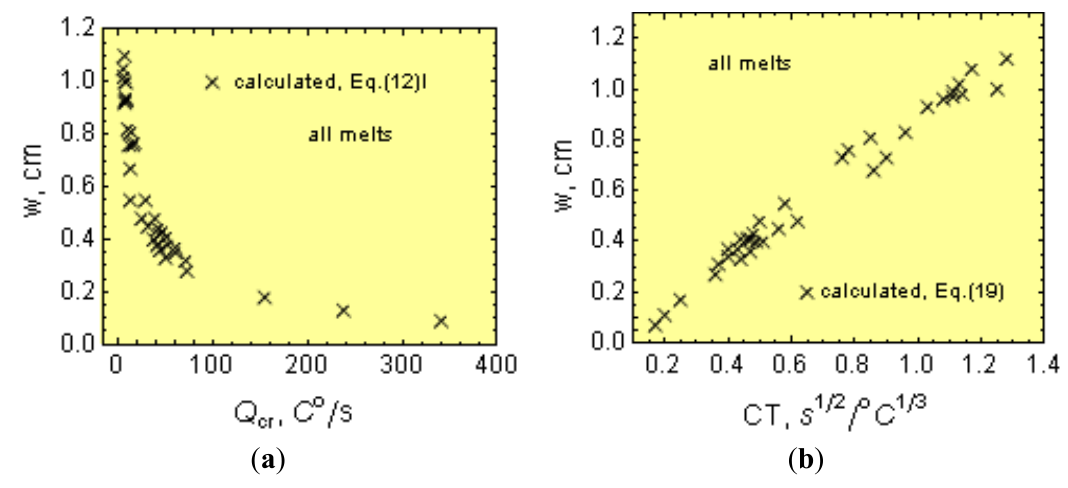
Figure 27. Relationship between ( a ) Q cr and the chill, w, and ( b ) the CT and w for all melts. Experimental and calculated values were found using Equation